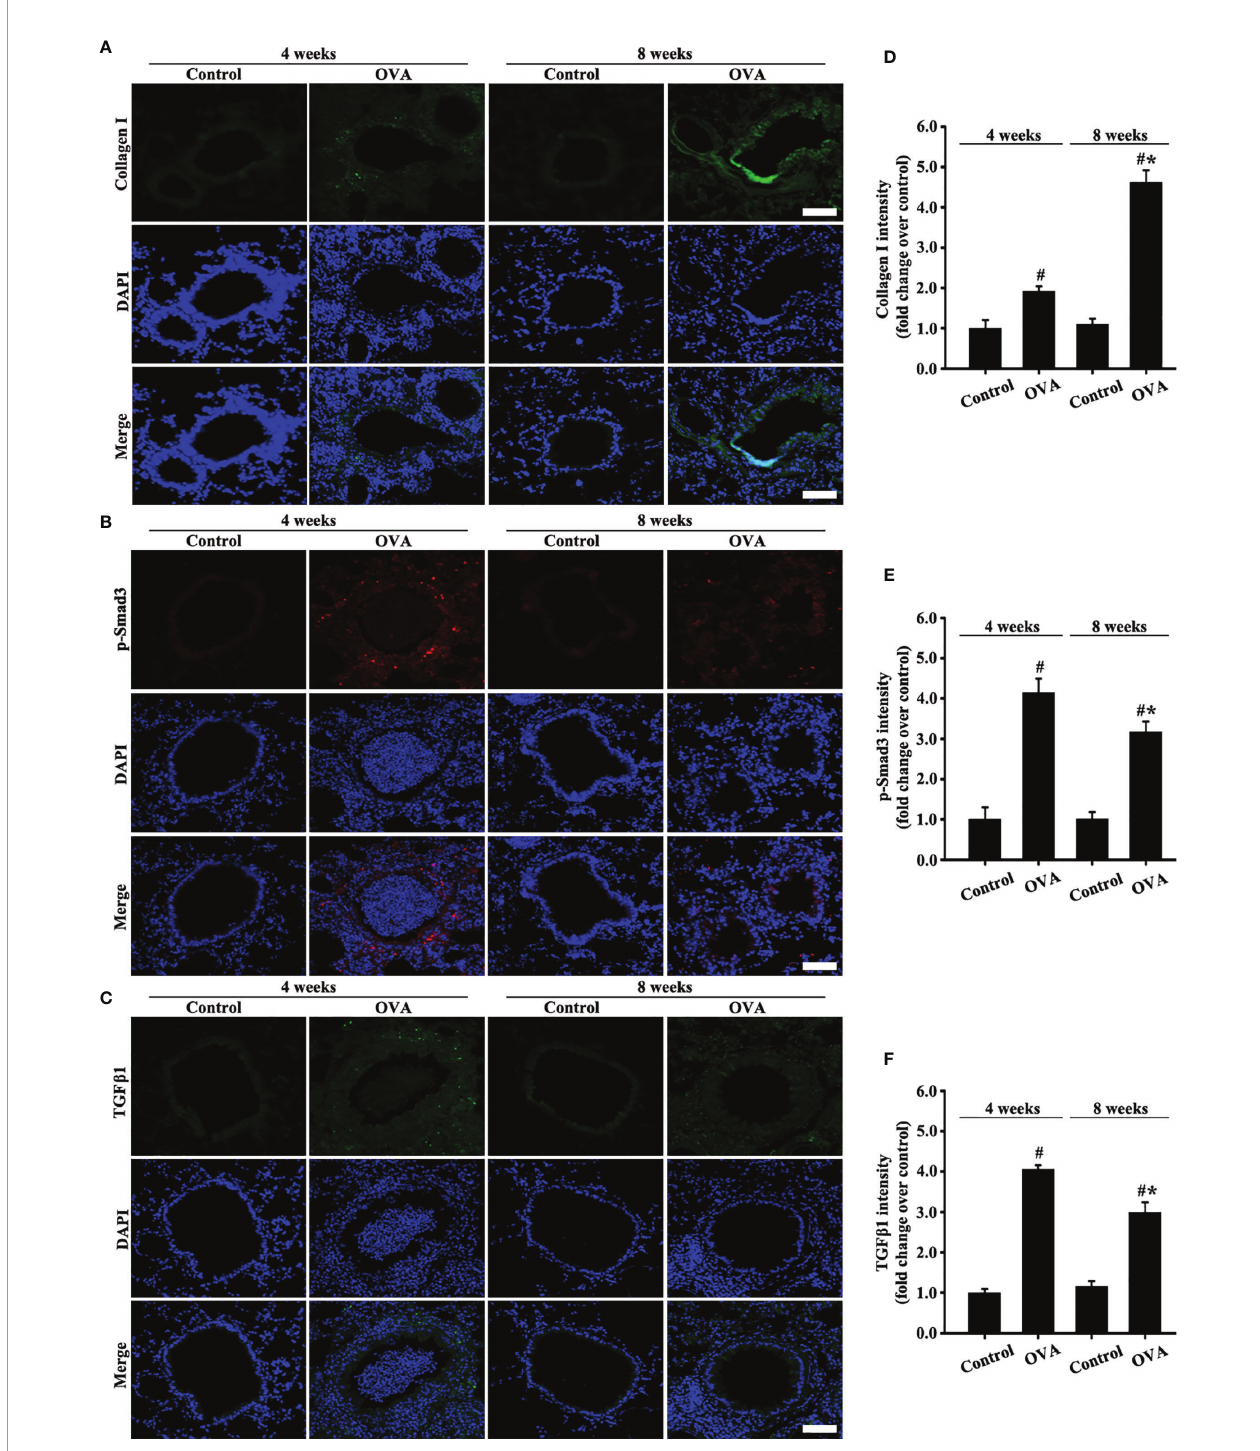
FIGURE 3 | Animal experimental schedule is shown in Figures 2A . Collagen I (A) , p-Smad3 (B) , and TGF b 1 (C) were detected by immuno fl uorescence. (D – F) Immuno fl uorescence intensity analysis of (A – C) , respectively. Data are shown as the means ± SD of three independent experiments. # p < 0.05 versus the control group. # *p < 0.05 versus the OVA (4 weeks) or control